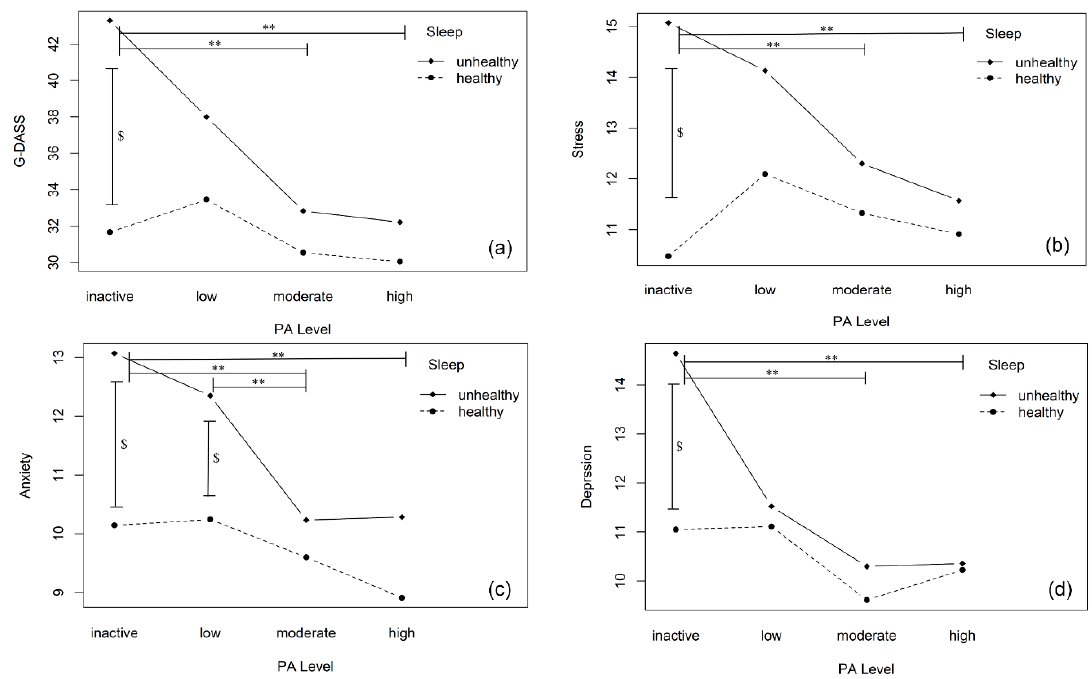
Figure 1. Effects of physical activity levels and sleep status on mental health. Note: PA, physical activity. G-DASS, global DASS, represents global negative emotions. The subgraph of ( a – d ) indicates the relationship between different PA levels and mental health indicators under healthy or unhealthy sleep status. Inactive, low, moderate, and high PA represent four incremental physical activity levels. Symbol ** indicates that there are significant differences at 0.05 level in mental health indicators among different levels of physical activity when sleep is at an unhealthy vs. healthy status. Symbol $ means there is a significant difference at 0.05 level observed in mental health indicators between healthy and unhealthy sleep under certain physical activity levels.